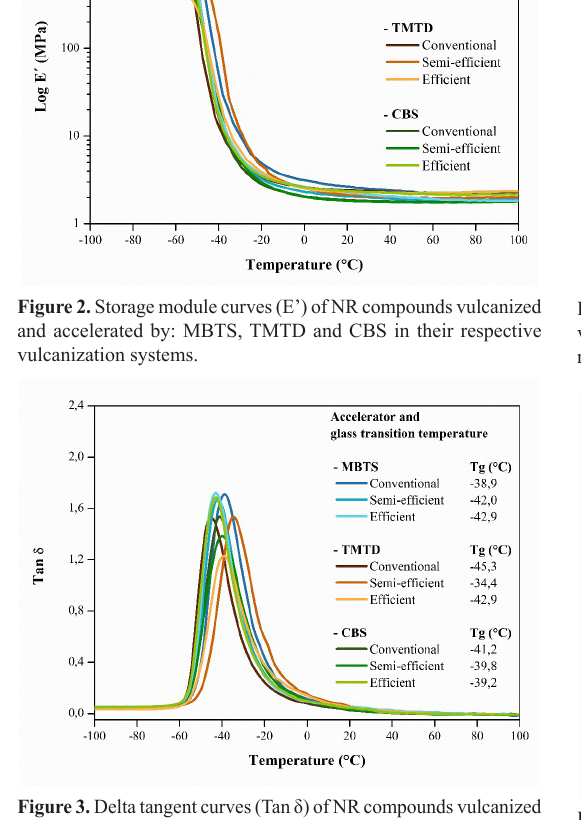
Figure 5. Normalized magnetization accumulation curves for NR compounds vulcanized and accelerated by TMTD in their respective crosslinking systems.